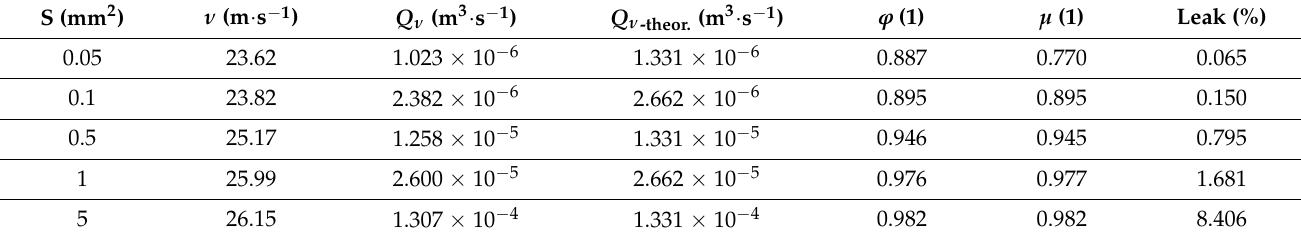
Figure 5. ( a ) Flow lines of the inhaled air with the leak areas of 0.5 mm 2 and ( b ) 5 mm 2 . Static pressure inside the mask was constant in all simulations. It was therefore possible to calculate the theoretical (maximum) velocity of the air flowing through the leaks using formula (5) with the coefficient of velocity equal to 1. The theoretical velocity was 26.62 m · s − 1 , and when this velocity value was multiplied by the cross-sectional area of the leak, the result was the theoretical air flow through the leak Q ν -theor . After identifying the true velocity and flow rate using numerical calculations of the air flow, it was possible to calculate the coefficient of velocity and the efflux coefficient. The resulting data are listed in Table 1. Table 1. Calculated parameters corresponding to the total cross-sectional area of the leak of the mask.